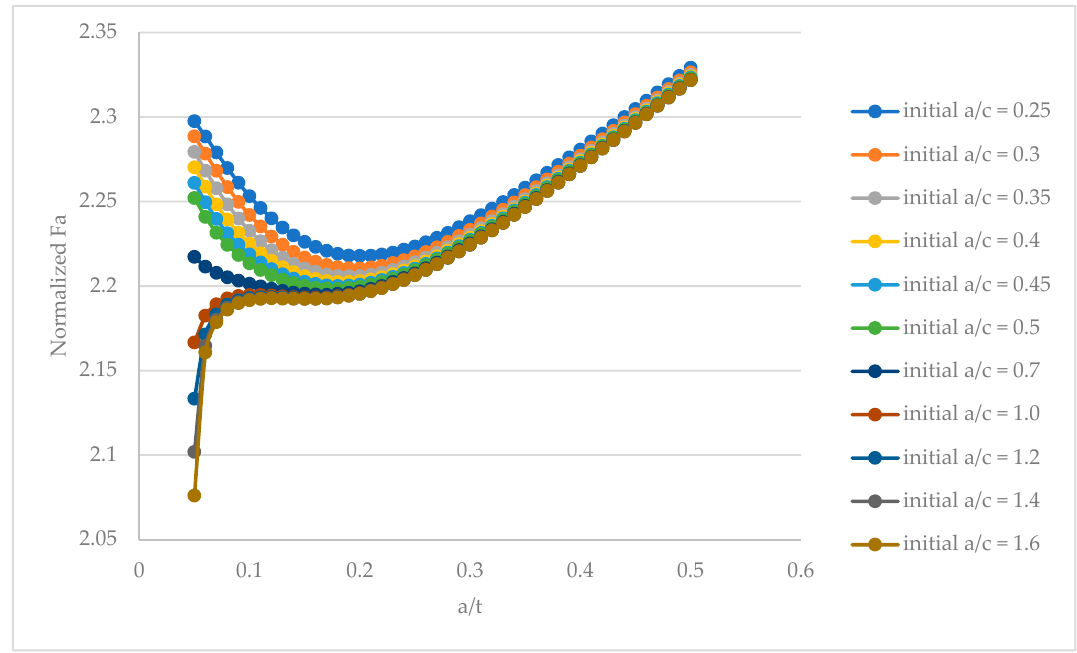
Figure A1. Polynomial fitting curves of the normalized F functions of Equation (16) for different initial external circumferential crack aspect ratios. The goodness of fit indicates more than 99%.